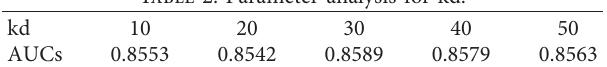
Table 2: Parameter analysis for